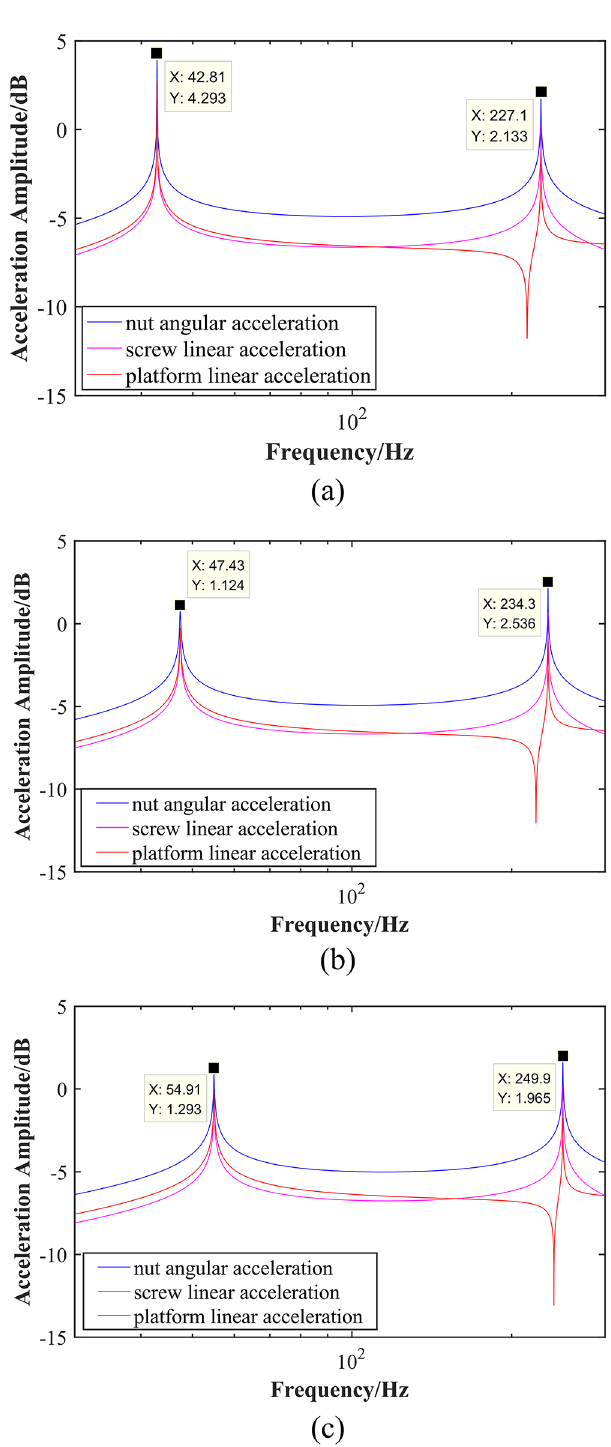
Fig. 5. Frequency responses of FDS (a) starting position (b) 0.25 of screw length (c) 0.5 of screw